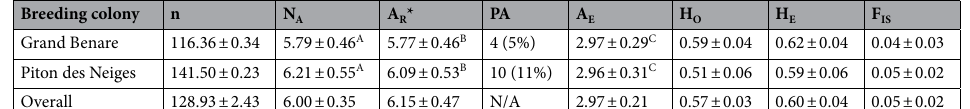
Table 1. Estimates of allelic diversity at two breeding colonies of the Barau’s Petrel ( Pterodroma baraui ), calculated across 14 polymorphic microsatellite loci. Indices of genetic diversity are as follows: n = mean number of individuals per locus ± S.E.; N A = mean number of alleles per locus ± S.E.; A R = mean allelic richness per locus ± S.E. (superscripts indicate statistical homogeneity among groups 46 ); PA = private allele richness (percentage of private alleles from total allelic richness in parenthesis); A E = mean number of effective alleles per locus ± S.E.; H O = mean observed heterozygosity over all loci ± s.e; H E = mean unbiased expected heterozygosity ± S.E.; F IS = mean fixation index ± S.E. calculated based on refs. 43,44 . *Estimate based on a minimum sample size of 114 diploid individuals.